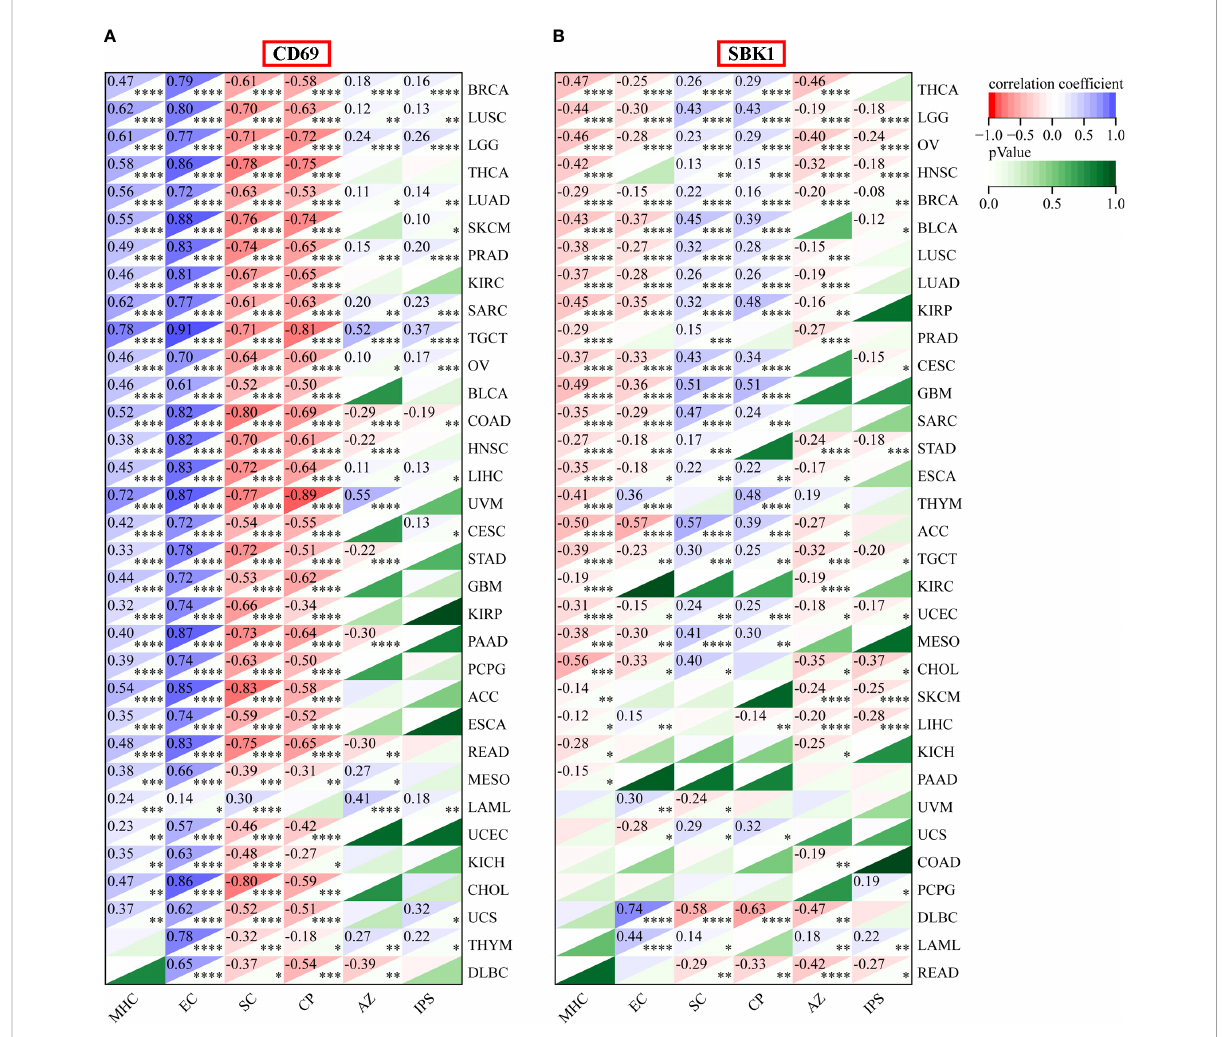
FIGURE 7 IPS analysis of CD69 and SBK1 in TCGA tumors. (A) CD69 levels positively correlate with IPS in various tumors. Top left corner: correlation coef fi cient. Lower right corner: p-value. (B) SBK1 levels negatively correlate with IPS in various tumors. MHC: major histocompatibility complex, CP, immune checkpoints; EC, effector cells; SC, suppressor cells; AZ, average z-scores. * indicates p<0.05. ** indicates p<0.01. *** indicates p<0.001. **** indicates